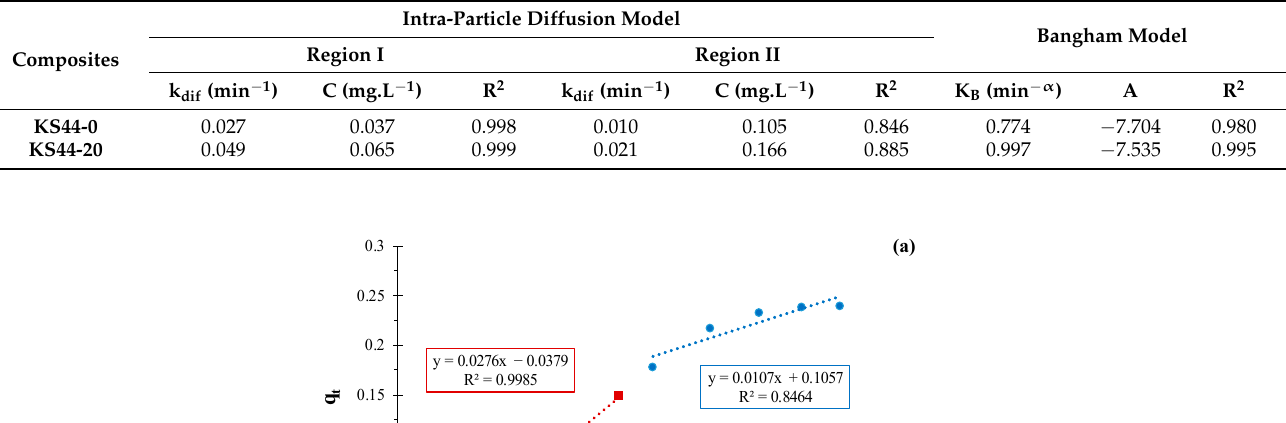
Figure 5. Intra-diffusion kinetic model representation for RhB adsorption on KS44-0 and KS44-20. Figure 5. Intra ‐ diffusion kinetic model representation for RhB adsorption on ( a ) KS44 ‐ 0 and ( b ) y = 0.9979x −7.5351 KS44 ‐ 20. R² = 0.9959 Table 3. Kinetic parameters obtained from intra-particle diffusion and Bangham models for RhB adsorption on KS44-0 and KS44-20.